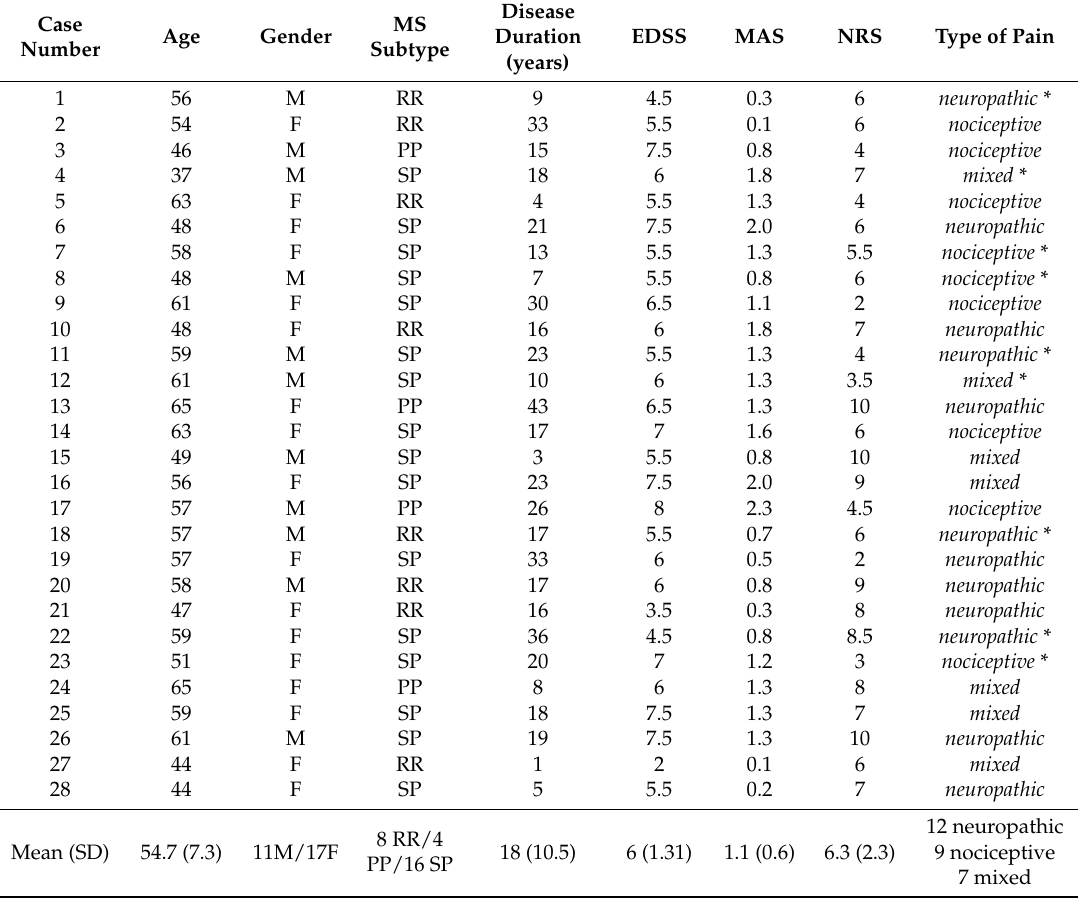
Table 1. Demographics and clinical features of multiple sclerosis (MS)